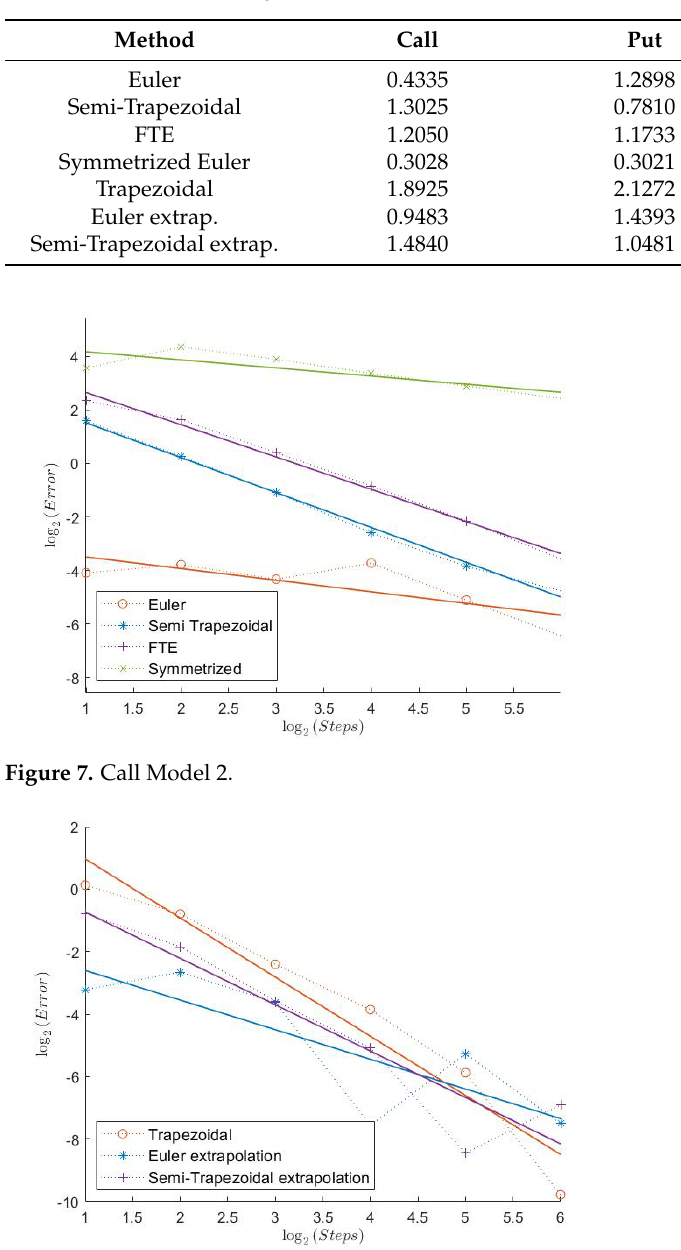
Figure 8. Call Model